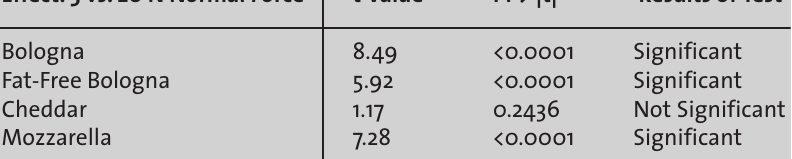
Table 4: G” values* of semi-solid samples loaded to 5 and 20 N at frequencies of 1, 10, and 100 Hz (frequency sweep, t = 20 Pa, n =6; *all values shown are the average of six